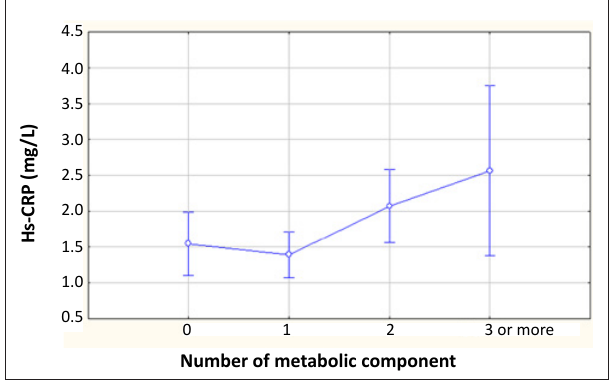
FIGURE 1: Association between the number of metabolic components and high-sensitivity C-reactive protein (Hs-CRP).